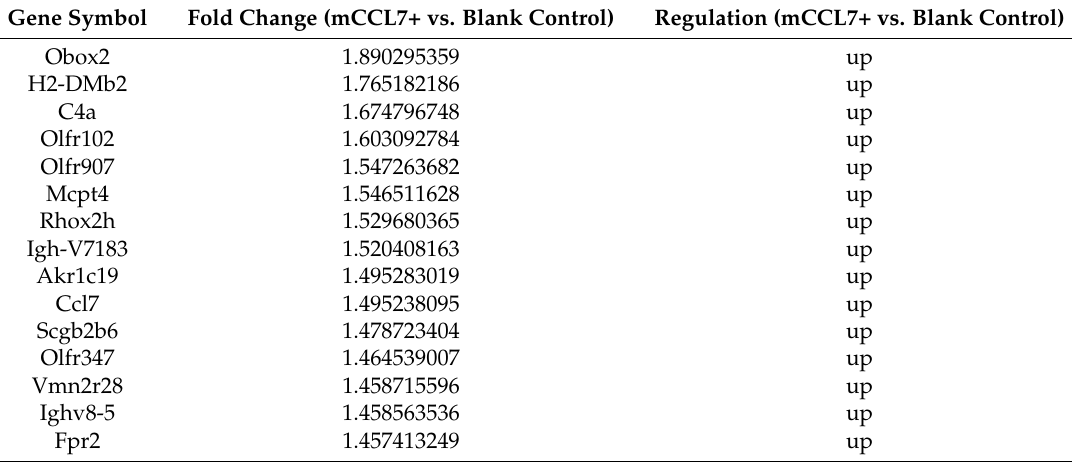
Table 3. Comparison of gene expression patterns of CCL7-overexpressing CT26 cells (mCCL7+) vs. blank control cells. Table depicts top upregulated genes. Gene Symbol Fold Change (mCCL7+ vs. Blank